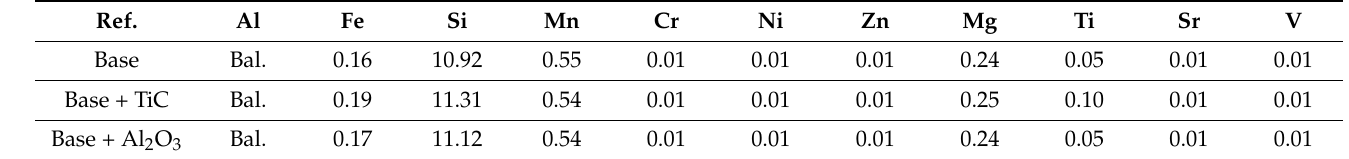
Table 1. Elemental composition (in wt %) of the molten alloys obtained by